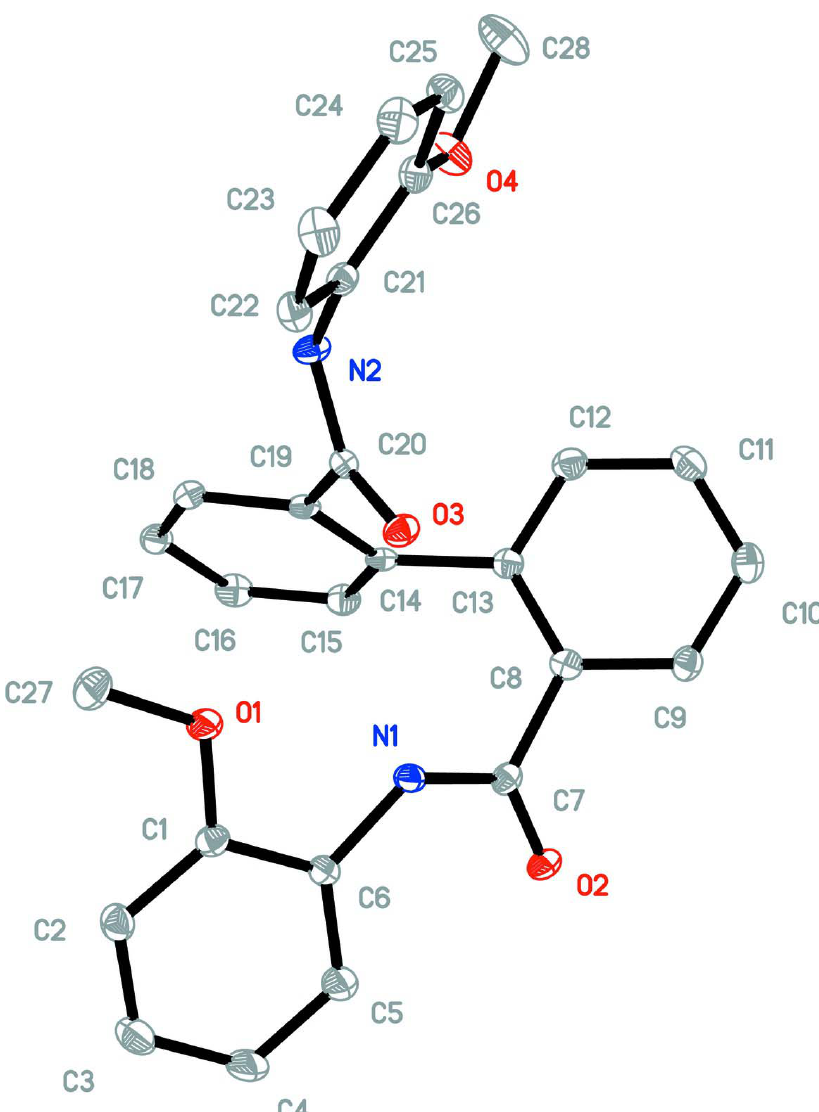
The molecular structure of the title compound, showing 30% probability displacement ellipsoids and the atomic